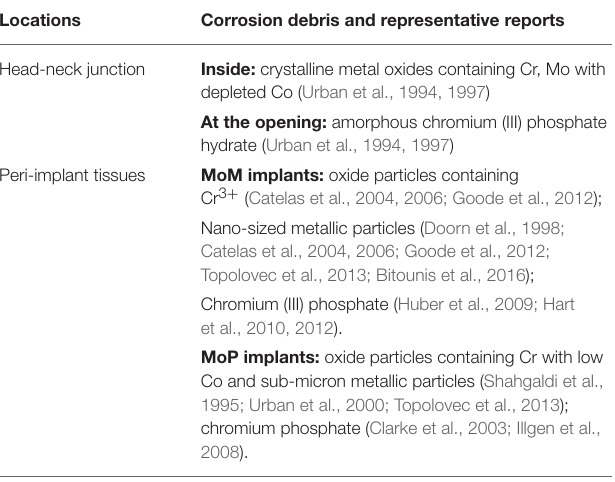
TABLE 1 | Summary of reported corrosion debris from CoCrMo hip implants.